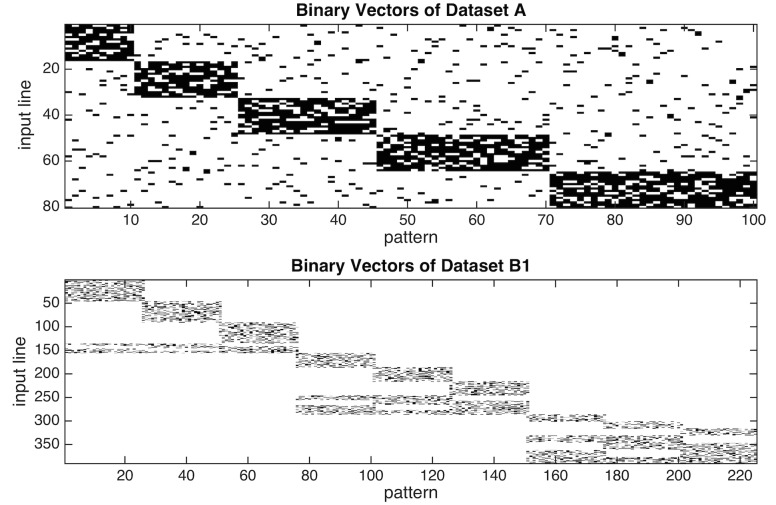
Randomly generated input vectors.(A) shows the 100 patterns of dataset A. An input pattern is built by perturbing one of five binary, 80-dimensional orthogonal vectors, see methods. Each of these five orthogonal vectors can be considered the central, unseen prototype pattern that defines the five distinct categories. The perturbation rule randomly complements two 1's and two 0's of such a prototype. Black pixels represent 1’s, and white pixels represents 0’s. Note the different relative frequencies of the categories: 10, 15, 20, 25, and 30%. (B) shows the 225 patterns of dataset B1. A pattern is built by perturbing each one of nine binary 390-dimensional vectors, see methods. Each of these nine vectors can be considered the central, unseen prototype that defines a distinct category. The perturbation rule randomly selects 20 out of 60 input lines from the central pattern to be active. Black pixels represent 1’s and white pixels represents 0’s. Note the three orthogonal super-categories, and note the differing overlaps of the categories across super-categories. The equal frequencies of each category only applies to dataset B1.